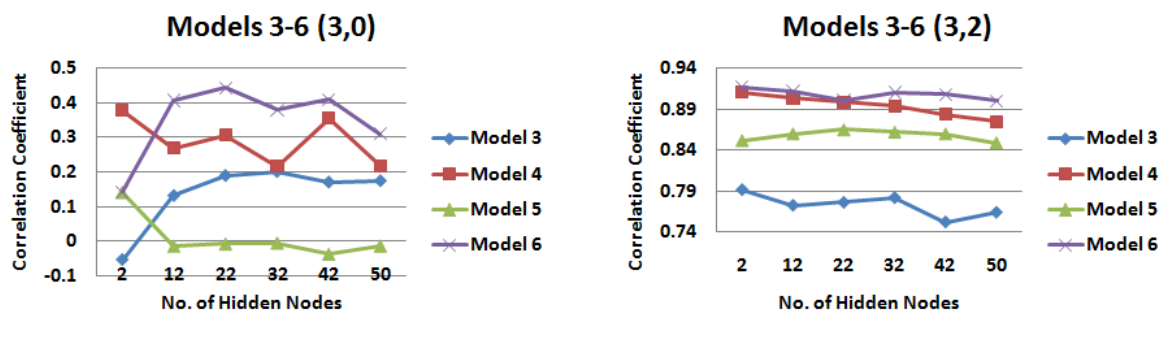
Figure 13. Correlation coefficients for input models 3–6 for 3 days of rainfall information and 0 and 2 days water level information— ( a ) Models 1 and 2 (3,0) ( b ) Models 1 and 2 (3,2) .